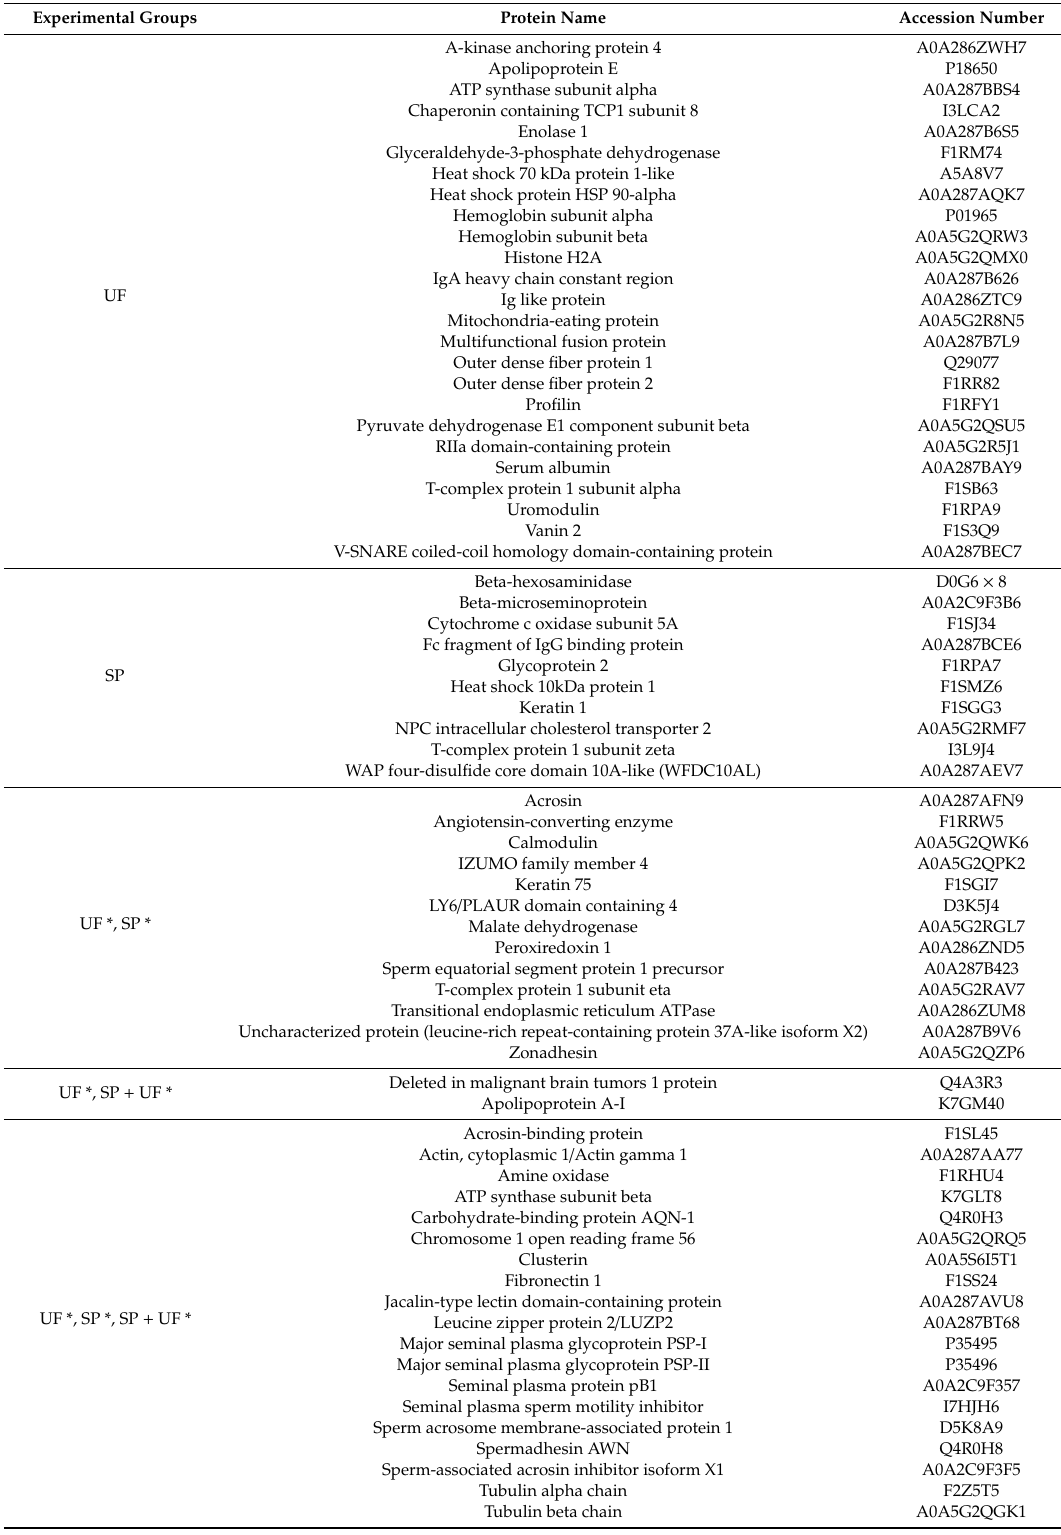
Table 1. List of boar spermatozoa proteins identified after incubation with uterine fluid (UF group), seminal plasma (SP group), and uterine fluid and seminal plasma (SP + UF